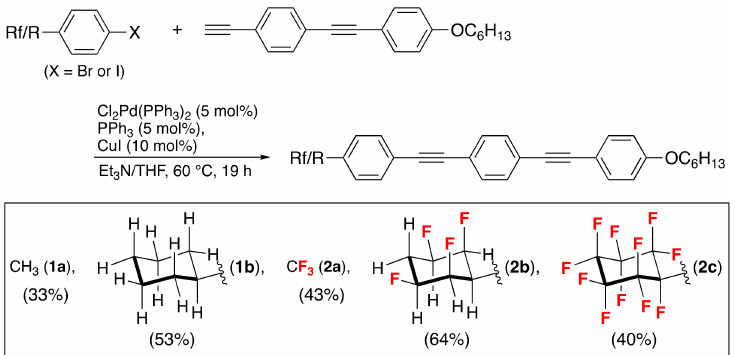
Figure 2. Synthetic procedures for the preparation of the bistolanes 1a , 1b , and 2a – 2c used in this